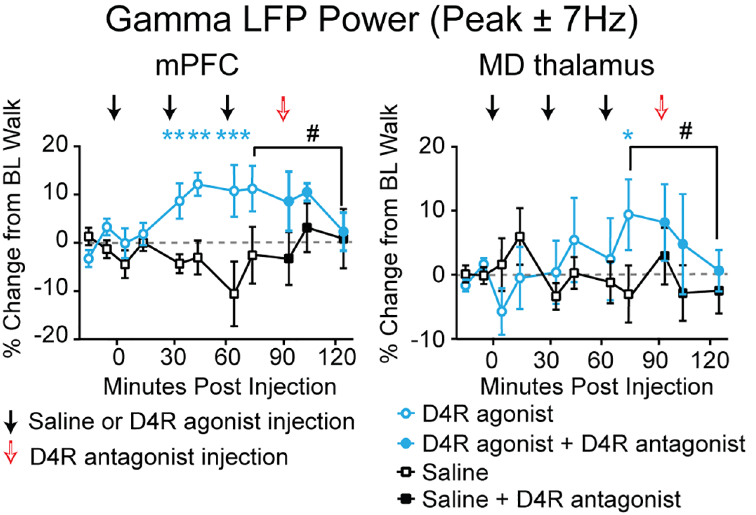
Fig 3. Effects of dopamine D4R agonist and antagonist on gamma power in the absence of ketamine. Percent change in total gamma power (peak between40 and 70 Hz ± 7 Hz, see Methods)in the mPFC ( left ) and MD thalamus( right ) of rats injected(at arrows) with either saline (black curve), or the D4R agonist A- 412997(blue curve) at different doses (0.3 mg/kg at 1 st arrow; 1.2 mg/kg at 2 nd arrow; 1.5 mg/kg at 3 rd arrow). The total dose was 3 mg/kg A-412997.The D4R antagonist L-745,870(5 mg/kg, red arrow, n = 6 rats) was injected90 min followingthe first injectionof either saline or A-412997. * : p < 0.05, *** : p < 0.001, significant difference from vehicleinjections,repeatedmeasuresone-wayANOVA with post-hoc pairedbootstrap tests with Bonferroni correction #: p < 0.05, pairedbootstraptest comparingpercent changein power 15 minutes after 3 mg/kg A-412997and 35 minutes after 5 mg/kg L-745,870.